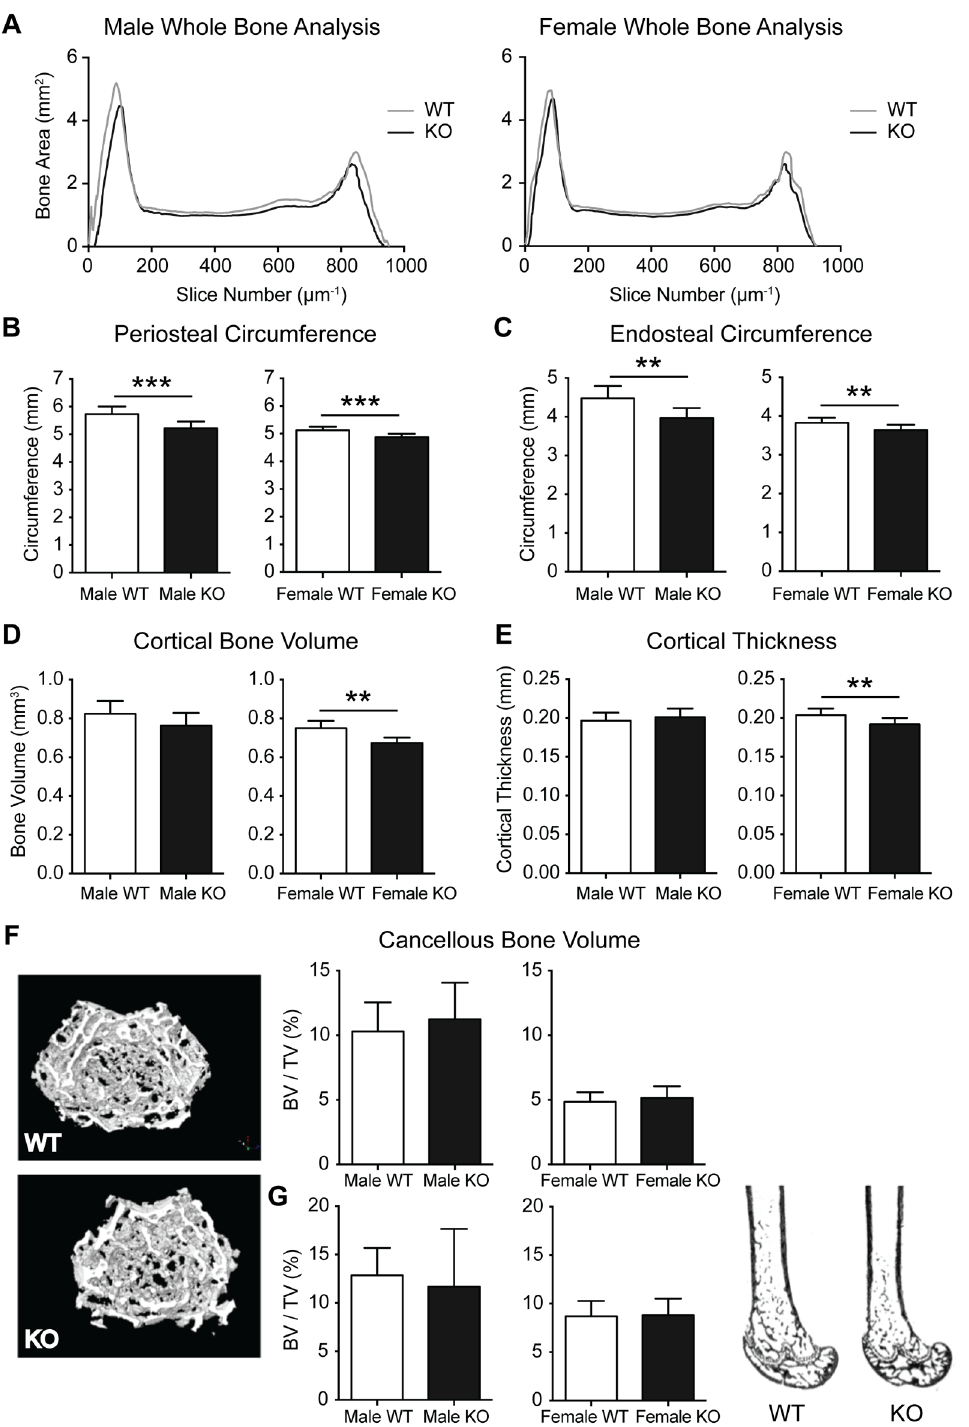
Fig 2. Cortical bone analysis of PWCR KO mice. A.) Whole bone analysis of male and female femurs of PWCR KO and WT mice using micro CT. Micro CT analysis of cortical bone on a standardised region of the femur diaphysis :- B.) periosteal circumference; C.) endosteal circumference; D.) cortical bone volume; and E.) cortical thickness. F.) Micro CT analysis of cancellous bone of the distal femur. G.) Representative images and histomorphometric analysis of sagittal femoral cancellous bone volume. n = 7 – 10 represented as mean ± SD. * p-value < 0.05, ** p-value < 0.01, *** p-value < 0.001.